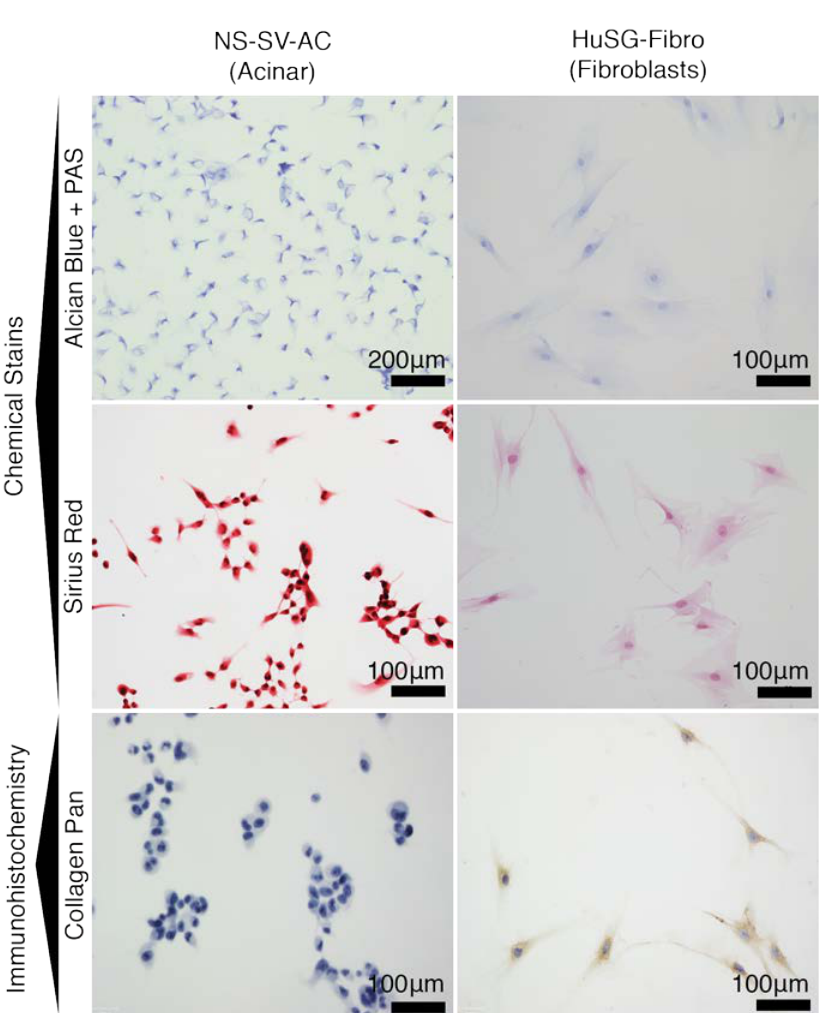
Figure A1. Graphical Representation of EYP’s Mean Protein Concentration as a Function of EpiMax Medium Concentration. Protein quantifications of EYP, EYP + Medium or Medium were performed with Bicinchoninic Acid assay. Error Bars = Standard Error. For statistical analysis (grey lines) we used one-way ANOVA followed by Tukey’s Post-Hoc test with p -values = * <0.05, ** < 0.01.